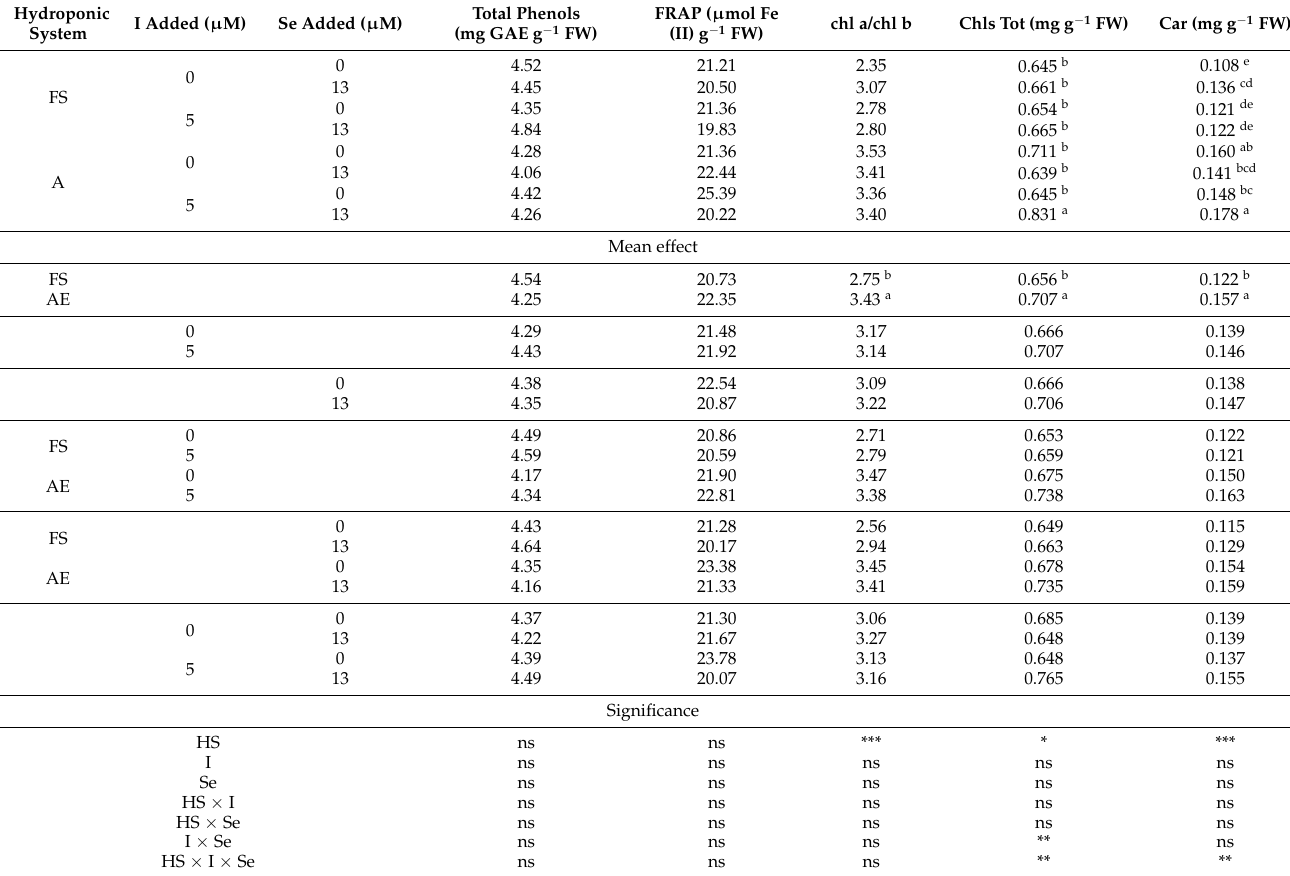
Table 3. Total phenols, antioxidant capacity (FRAP), chlorophyll a to b ratio (chl a/chl b), total chlorophyll, and carotenoid contents, measured at harvest, in leaves of lettuce plants grown in two different hydroponic systems (HS), floating (FS) and aeroponics (AE), and at different concentrations of I and Se in the nutrient solution, in the first experiment. Hydroponic